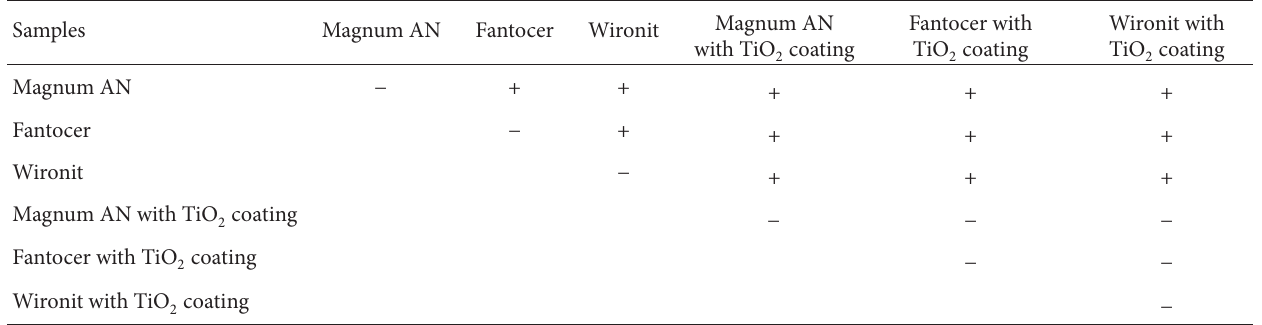
Table 2: The Bonferroni test between all pairs of tested groups ( 𝑃 < 0.05